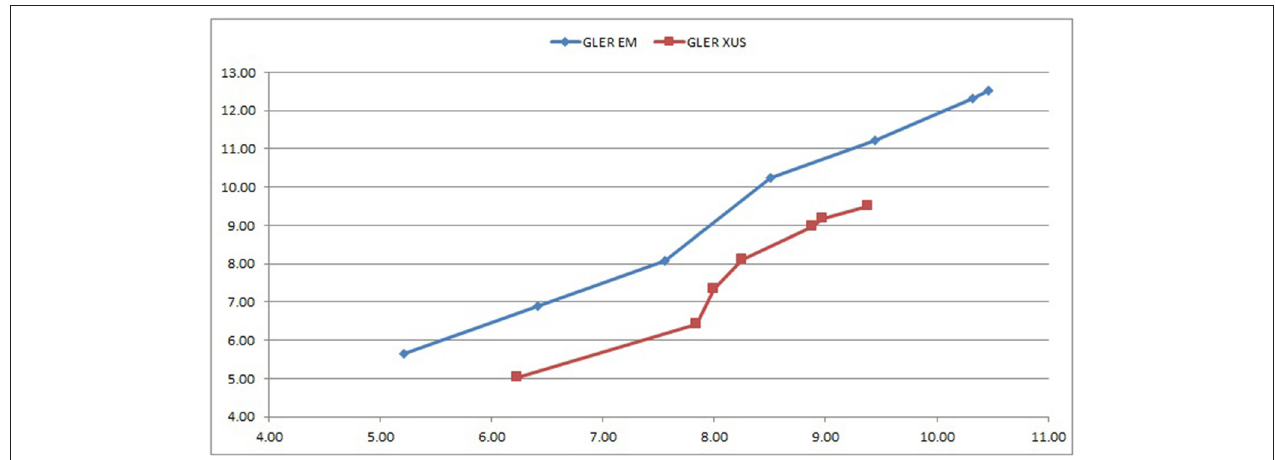
FIGURE 3 | Targeted tracking errors and realized excess